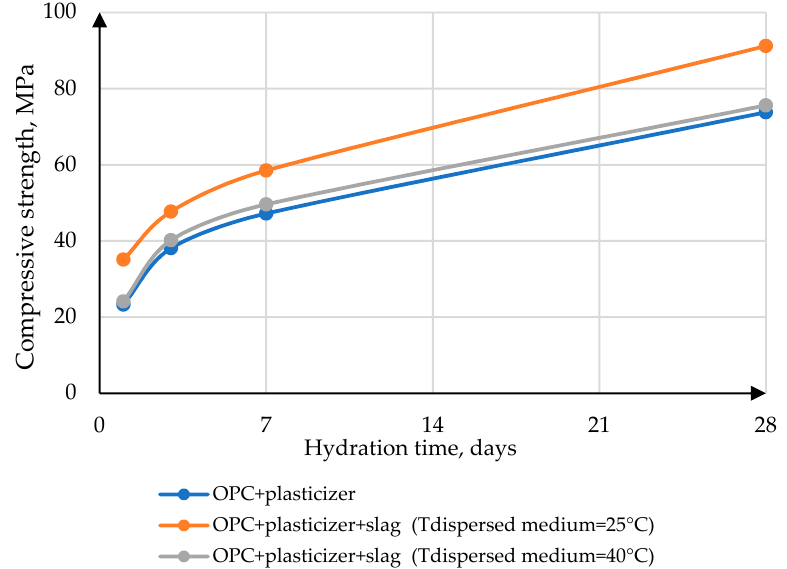
Figure 15. The e ff ect of stabilized slag suspensions processed at di ff erent temperatures of the dis- Figure 15. The effect of stabilized slag suspensions processed at different temperatures of the persed medium on the compressive strength of samples. dispersed medium on the compressive strength of samples.